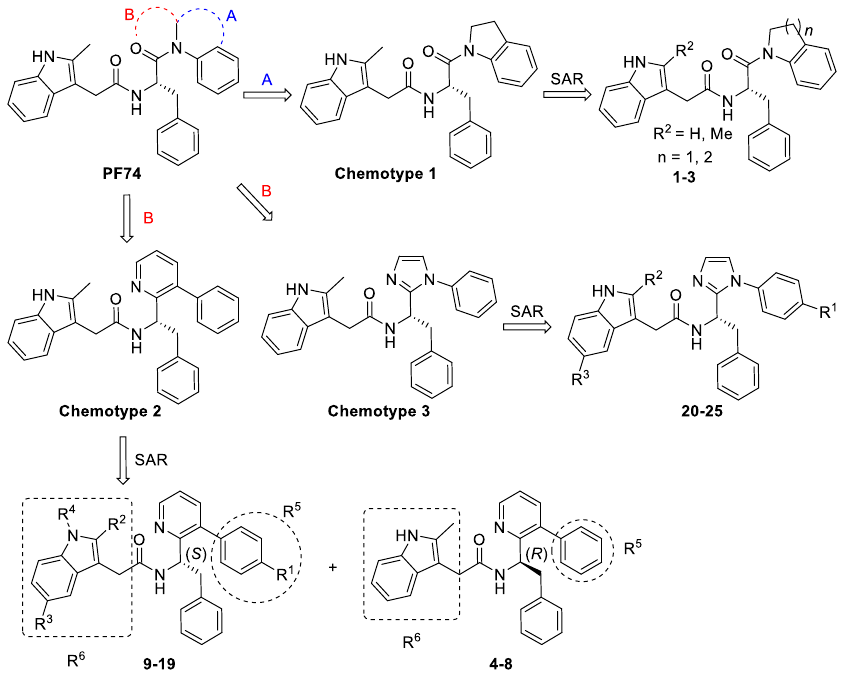
Figure 2. Design of conformationally constrained chemotypes based on PF74.